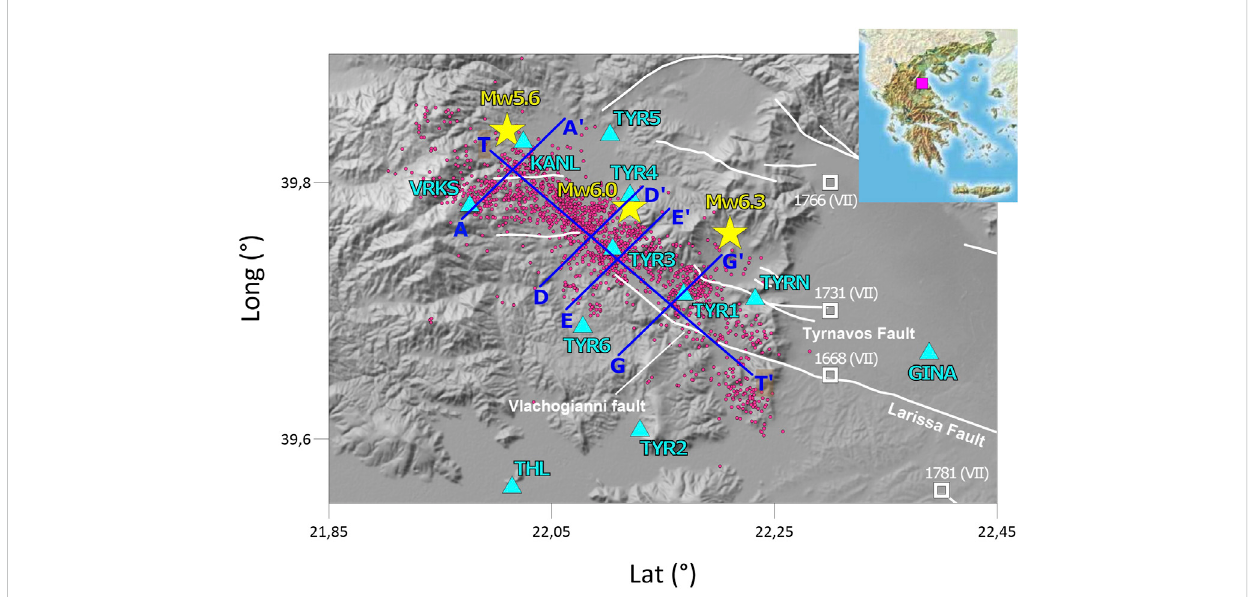
FIGURE 1 Study area and seismological data with main tectonic lineaments (white lines) redrawn after Caputo and Pavlides (1993). Historical earthquakes in Thessaly area (Caputo and Helly, 2005b) are shown with white squares, including the maximum intensity, I MAX , of each event in brackets (data by Caputo et al., 2006). The March-April 2021 aftershock sequence relocated through the 3D tomographic inversion is shown with magenta circles. Cyan triangles representtheseismicnetworkusedinthisstudytoperformtheseismictomography.YellowstarsarethethreestrongesteventsoftheTSS.Tracesof the vertical tomographic cross-sections are shown with blue